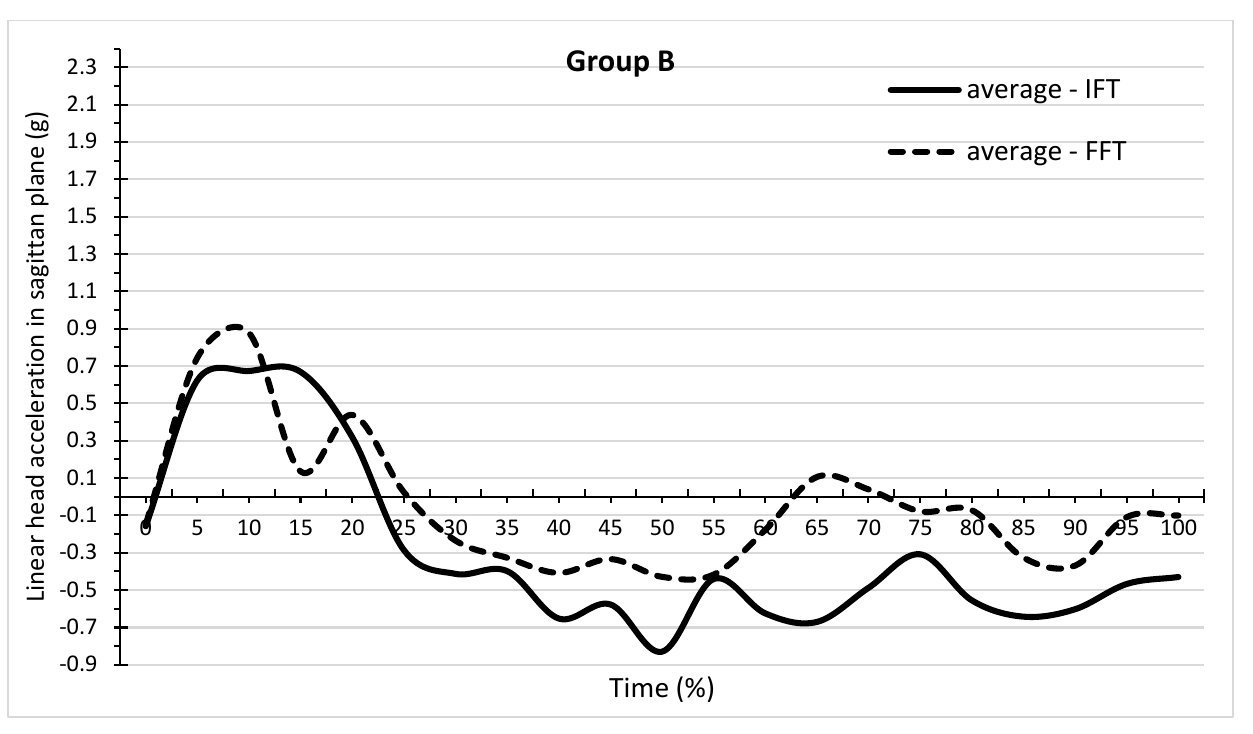
Figure 5. Dependence of mean values of linear head acceleration in the sagittal plane on the time of performing a backward fall in the form of IFT and FFT in group A, which consisted of students training in martial arts.